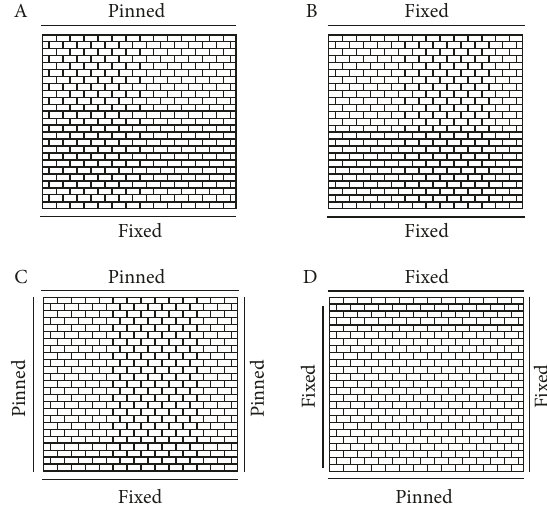
Figure 6: Detail of boundary conditions. the same scaled distance 4.5 m/kg 1/3 as shown in Figure